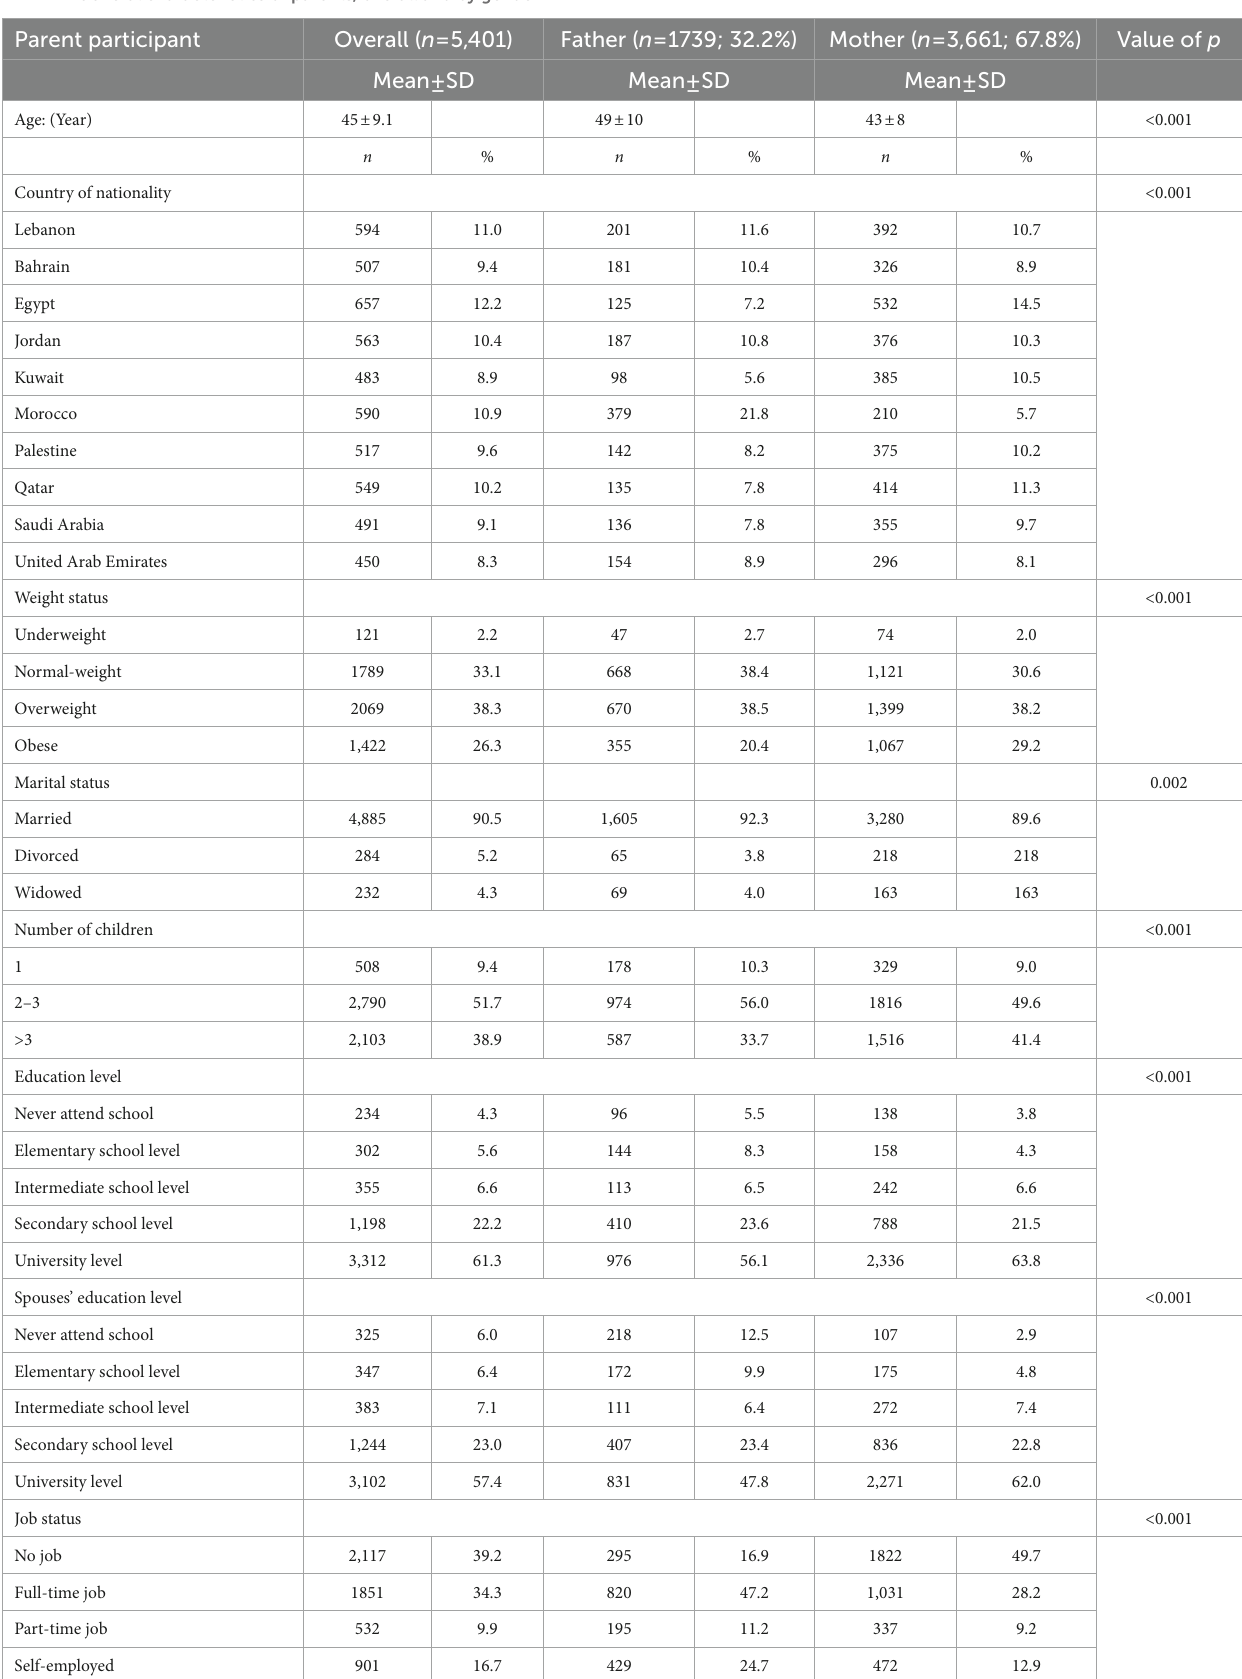
TABLE 2 General characteristics of parents, overall and by gender. Parent participant Overall ( n = 5,401) Father ( n = 1739; 32.2%) Mother ( n = 3,661; 67.8%) Value of p Mean ± SD Mean ± SD Mean ±